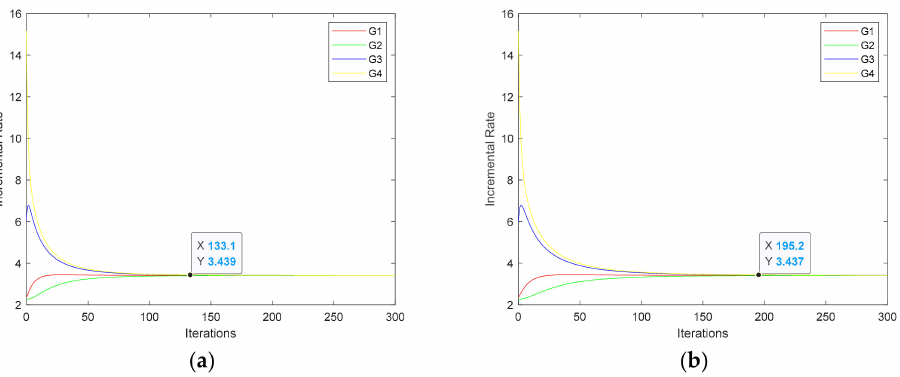
Figure 15. The rate of micro-increase. ( a ) The rate of micro-increase in fixed-time consistency at the random delay; ( b ) The rate of the K-step average consistency algorithm at the random